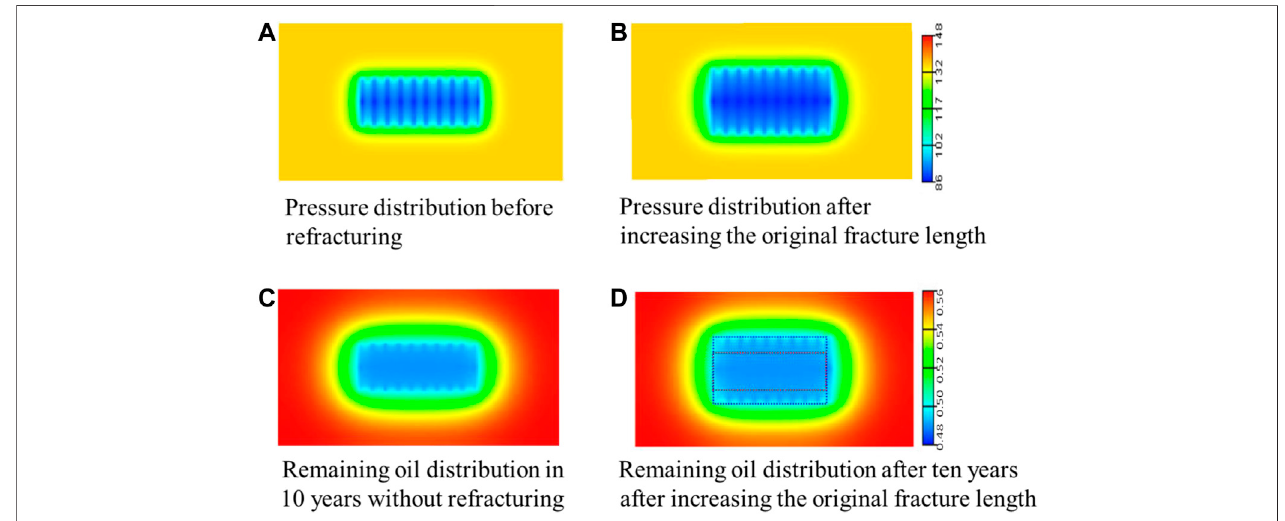
FIGURE 10 | Pressure distribution before and after increasing original fracture length and remaining oil distribution in 10 years of production. (A) Pressure distribution before refracturing (B) Pressure distribution after increasing the orginally fracture length. (C) Remaining oil distribution in 10 years without refracturing. (D) Remaining oil distribution after ten years after increasing the orginally fracture length.